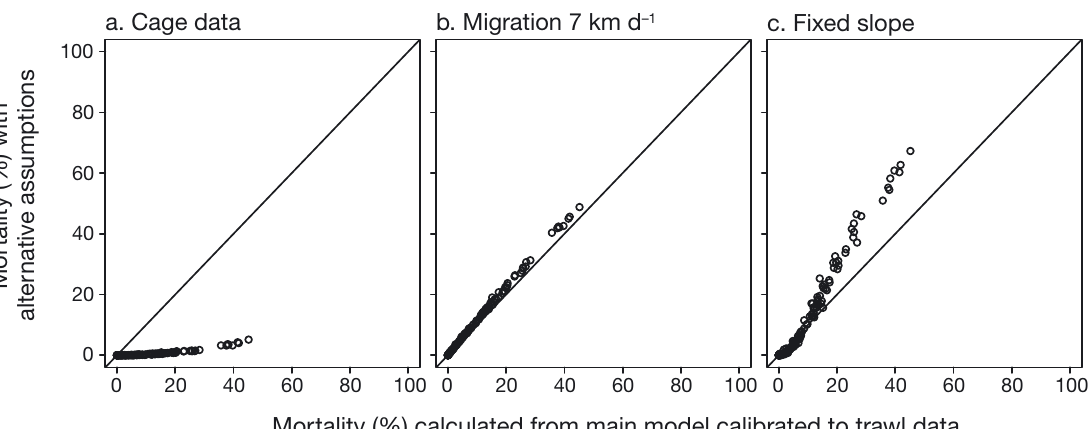
Fig. 6. Sensitivity of salmon lice-induced mortality predictions to alternative model assumptions. The x -axis in each panel shows the salmon lice-induced mortality for each management area (MA) and year calculated by the main model calibrated to trawl data (as in Fig. 5). This model assumes a migration speed of the seaward-migrating post-smolts of 10 km d −1 and esti- mates the slope ( β 1 ) of the relationship between ln-scale infestation pressure and ln-scale expected lice abundance from the data. The y -axis in each panel shows mortality calculated using alternative assumptions: (a) calibrating the model to cage data, (b) assuming a migration speed of 7 km d −1 or (c) fixing β 1 to 1. Diagonal lines show the 1:1